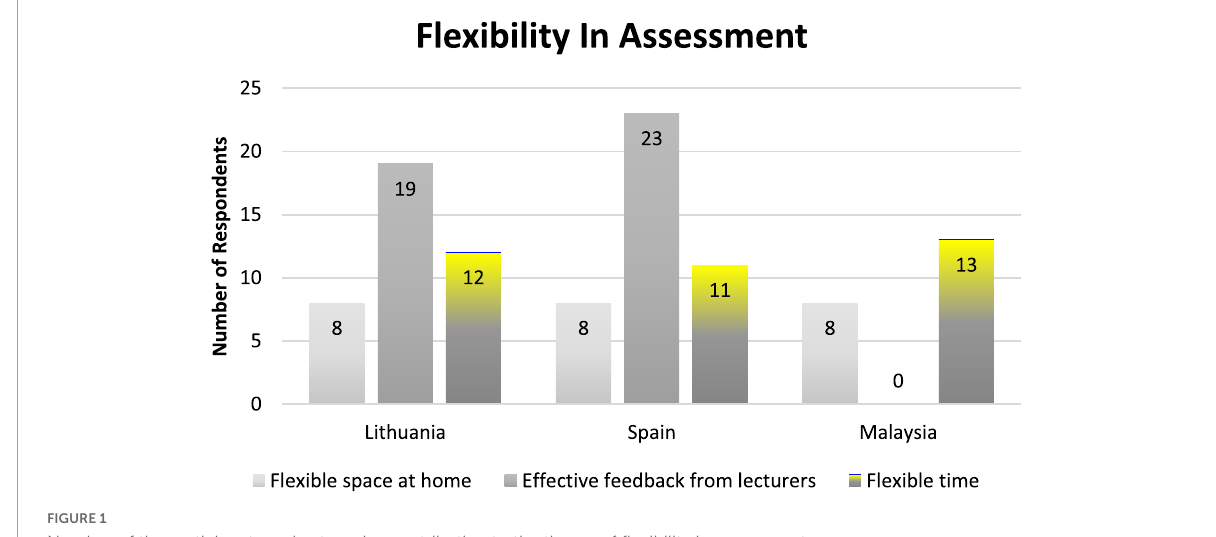
FIGURE1 Number of the participants and categories contributing to the theme of flexibility in assessment.